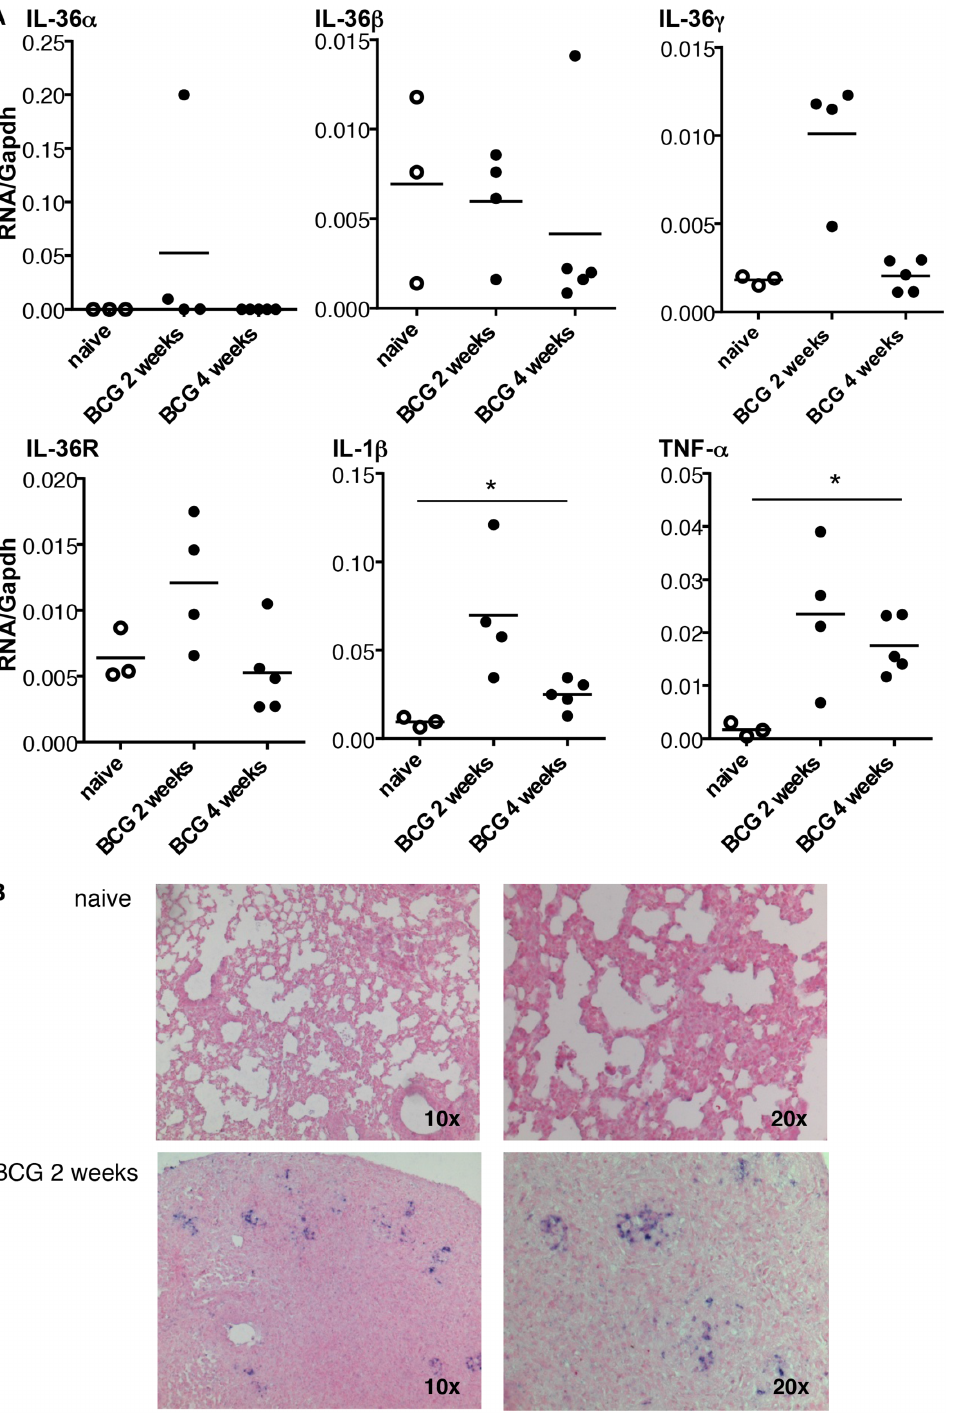
Fig 2. Kinetic of IL-36 cytokines, IL-36R, IL-1 β and TNF- α mRNA expression after M . bovis BCG infection. mRNA levels of Il36a , Il36b , Il36g , Il36r , Il1b , and Tnfa measured by RT-qPCR and normalized to Gapdh mRNA levels from the lungs of C57BL/6 wild-type mice 2 weeks (n = 4) and 4 weeks (n = 5) after M . bovis BCG infection. Three na ï ve mice were included as controls (A). In situ hybridization was performed using a digoxigenin-labeled riboprobe complementary to Il36g mRNA (B). The micrographs are representative of lungs from one na ï ve mice (upper panel) and one infected mice 2 weeks after M . bovis BCG inoculation (lower panel). * P < 0.05, as assessed by Kruskal-Wallis, followed by Mann-Whitney test.